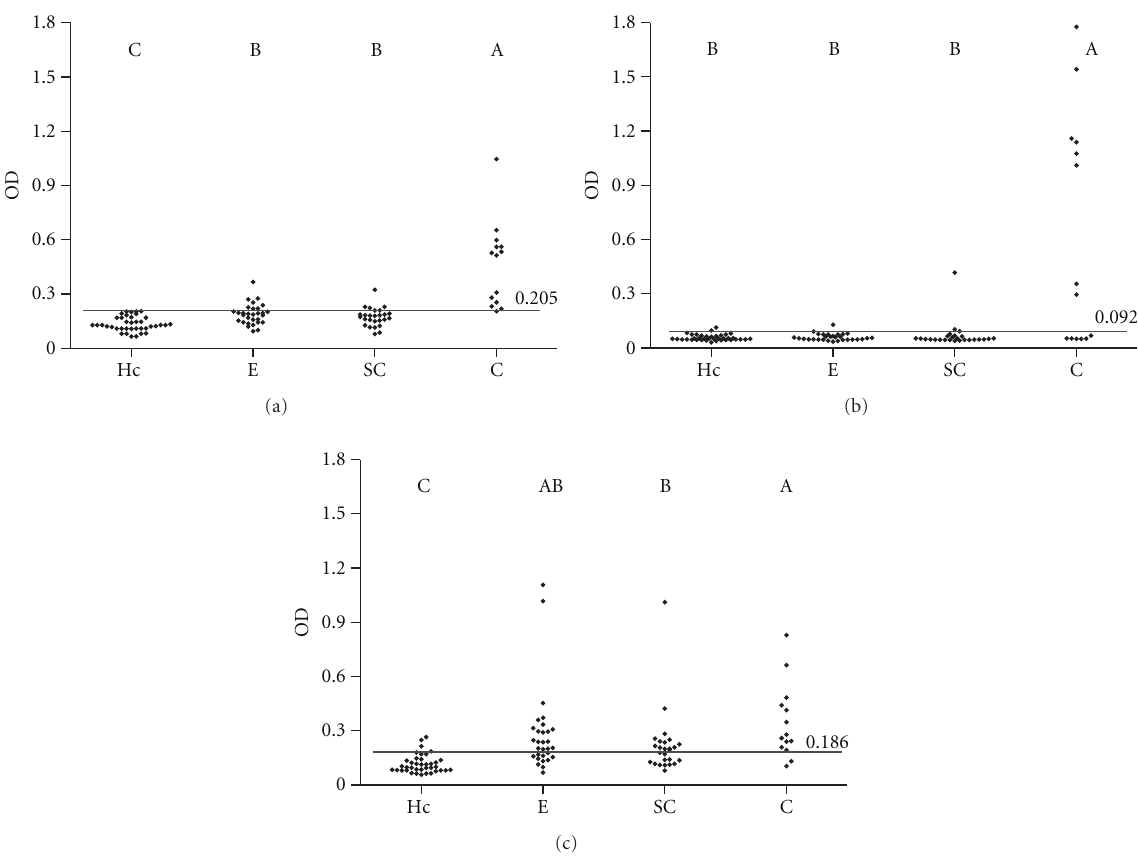
was calculated as % of cattle from the healthy control group testing negative at the cut-o ff chosen. ROC curves for IgG, IgG1 and IgG2/PPA-ELISAs of subclinically and clinically infected cattle were constructed as plots of sensitivity versus 100 minus specificity for each possible cut-o ff [30, 31].